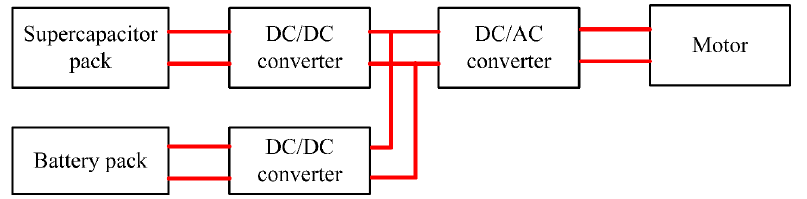
Figure 4. HES topology for an electric loader.